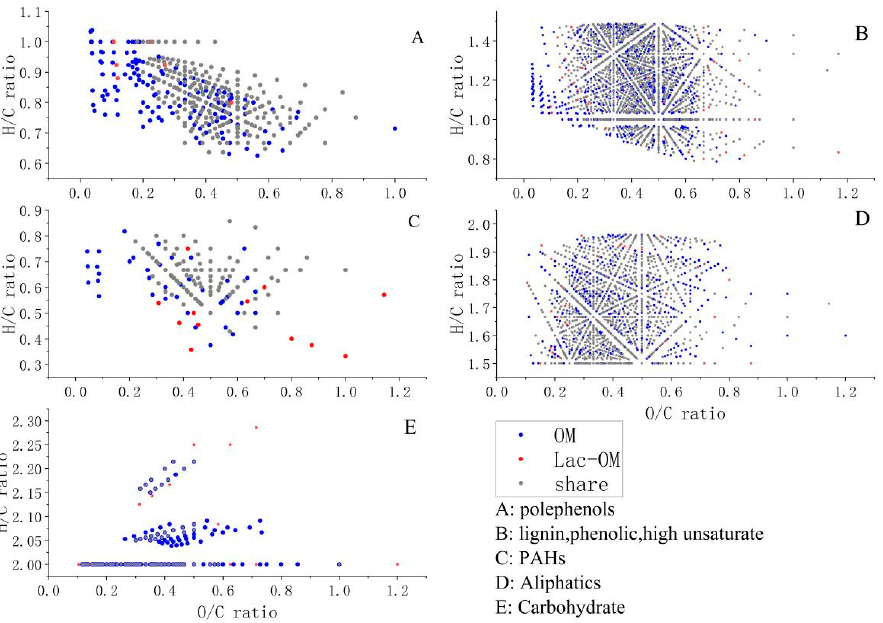
Figure 2. Van Krevelen plot of organic matter derived from leaf and laccase-modified organic mat-